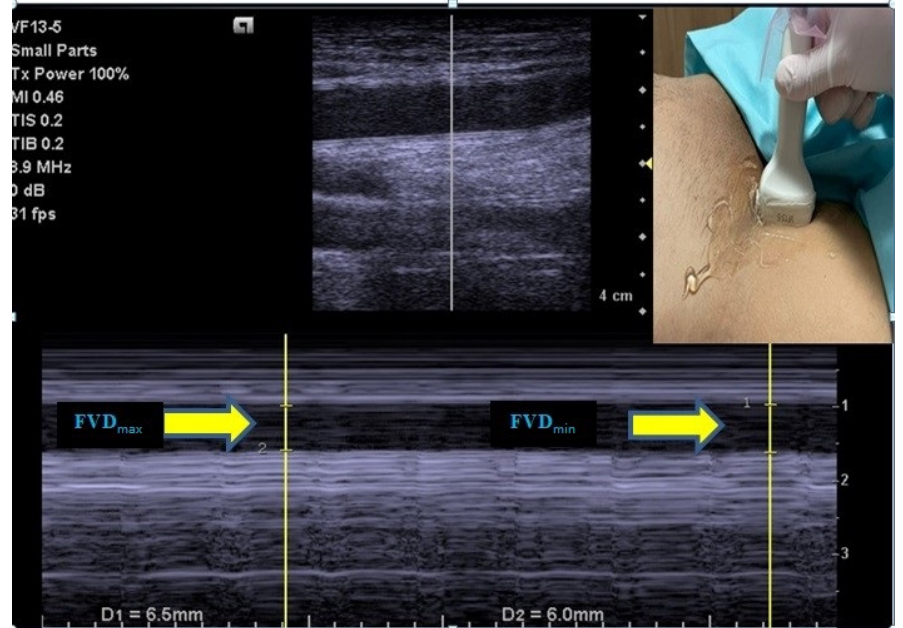
Figure 1. Maximum and minimum diameter measurements of the femoral vein.